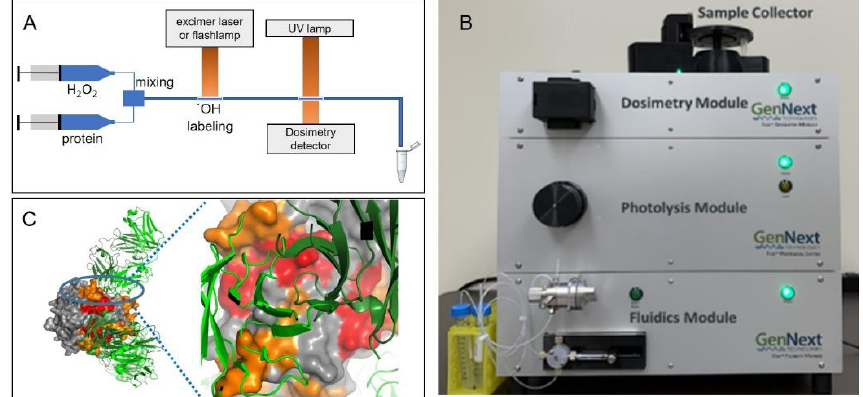
Figure 4. ( A ) Overview of the FPOP experiment. Protein is rapidly mixed with hydrogen peroxide; a UV laser or flashlamp is used to photolyze the hydrogen peroxide and produce hydroxyl radicals, which oxidatively modify accessible protein side chains. An optional inline dosimeter such as that described in [20] can be used to monitor dosage. Samples typically exit the apparatus into scavenging buffer. ( B ) A commercial FPOP system that uses a flashlamp for hydroxyl radical generation. ( C ) FOX system HRPF protection of TNF α plotted on the X-ray crystal structure of the TNF α -adalimumab Fab hexameric complex. Figure 4C is reproduced from [20], used with permission.